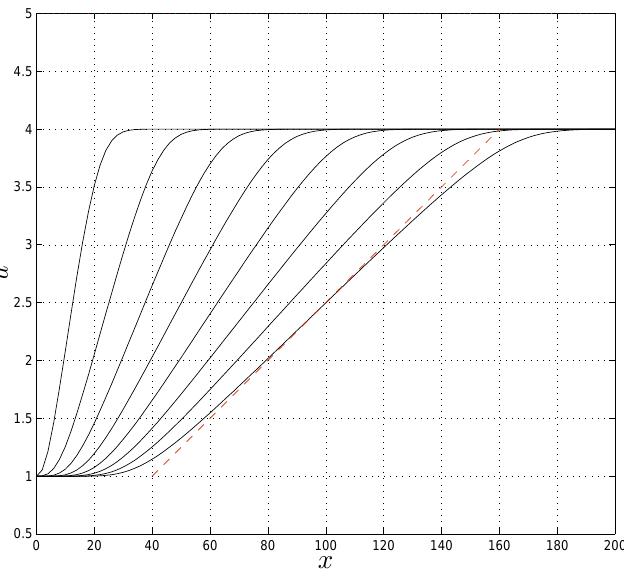
Figure 6: The occurrence of the EW with the solid lines showing the numerically computed solutions and the red dash line rep- resenting the predicted